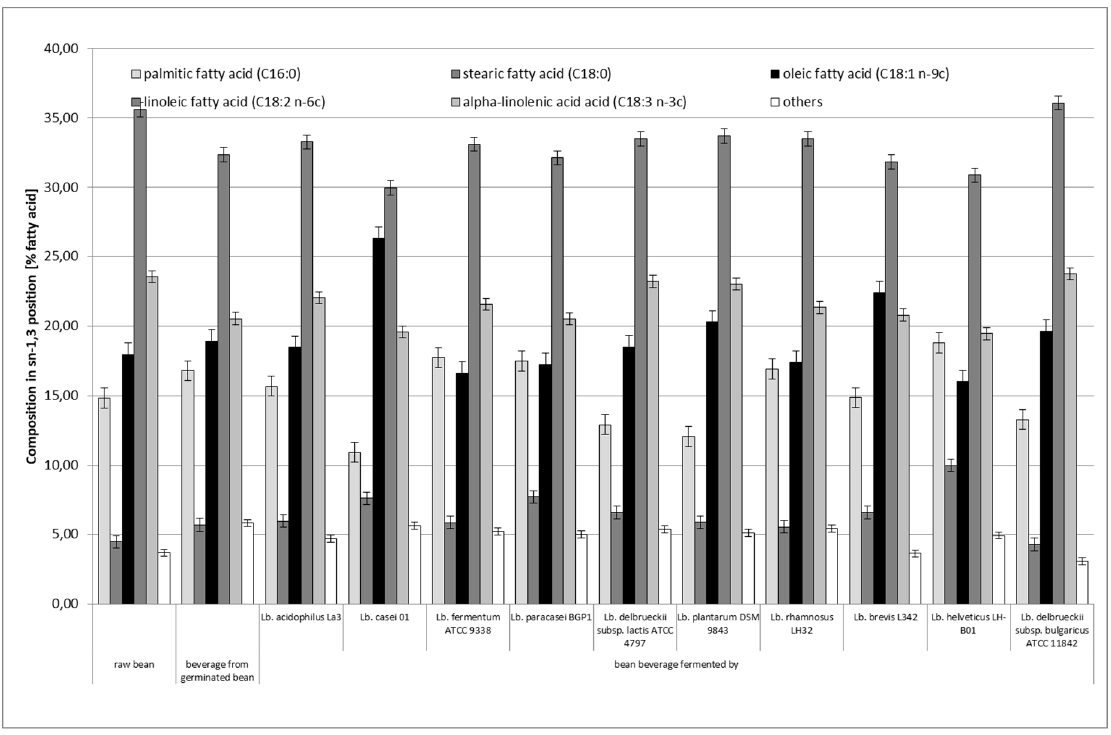
Figure 3. Positional distribution (sn–1,3) of fatty acids in triacylglycerols obtained from raw bean and bean–based beverages before and after fermentation process (means ± standard deviations, n = 4). Other minor fatty acids include 14:0, 16:1, 17:0, 20:0, and 22:0.